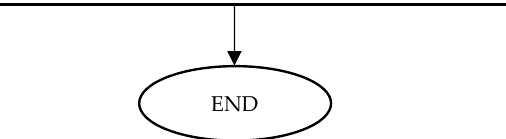
Figure 3. Flow chart depicting experiments conducted based on hill climbing technique to tune and determine optimum architecture for